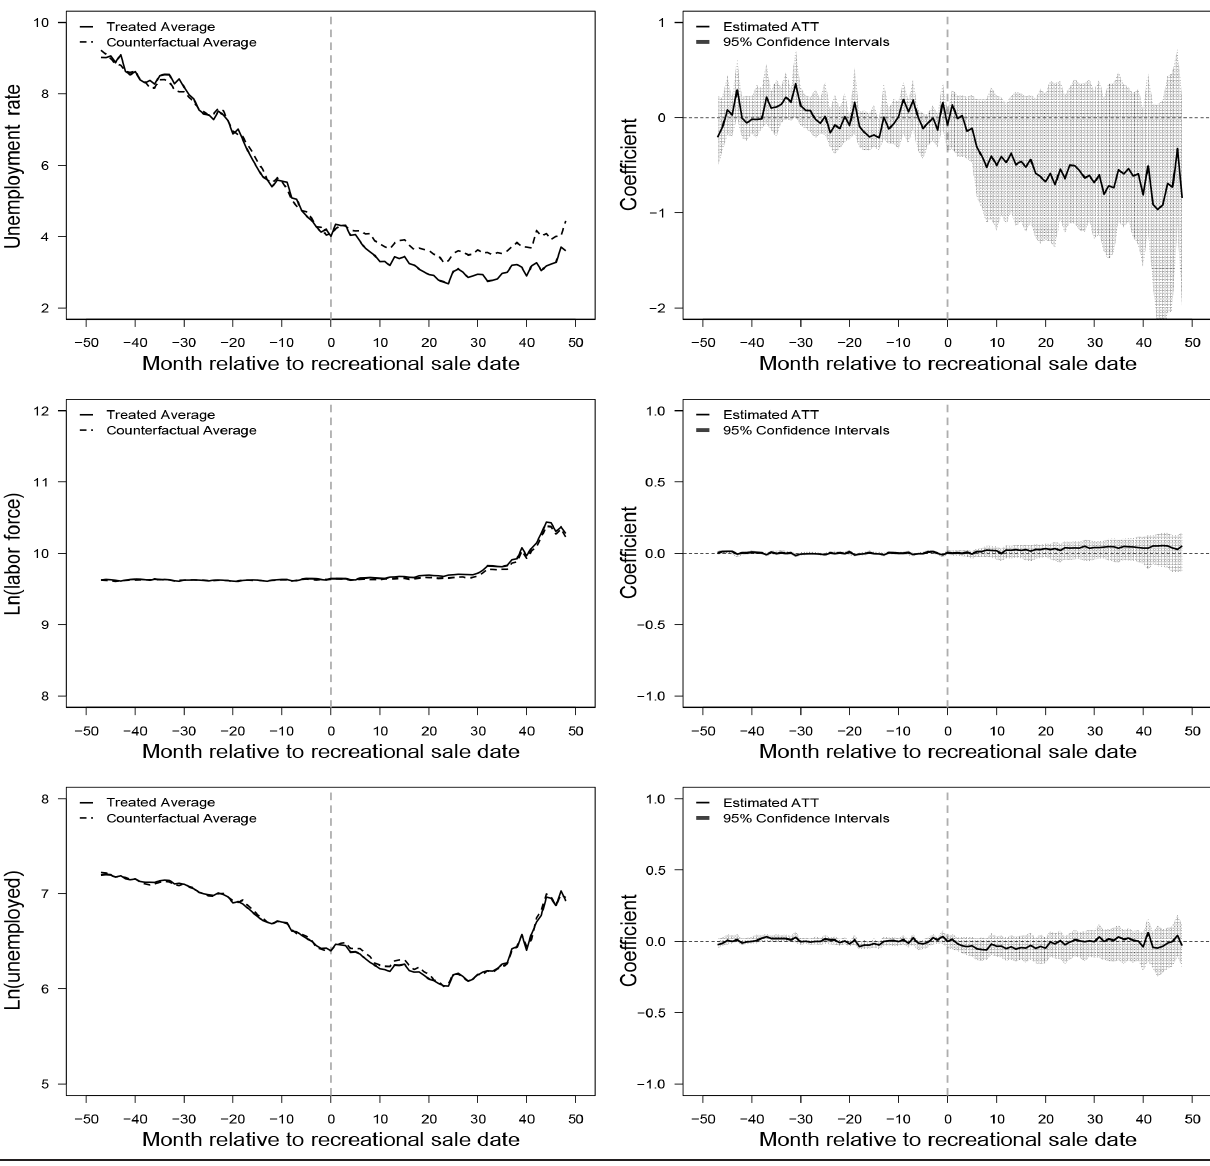
Figure A12 The effect of recreational dispensary entry on the unemployment rate, Ln(labor force), and Ln(unemployed) –